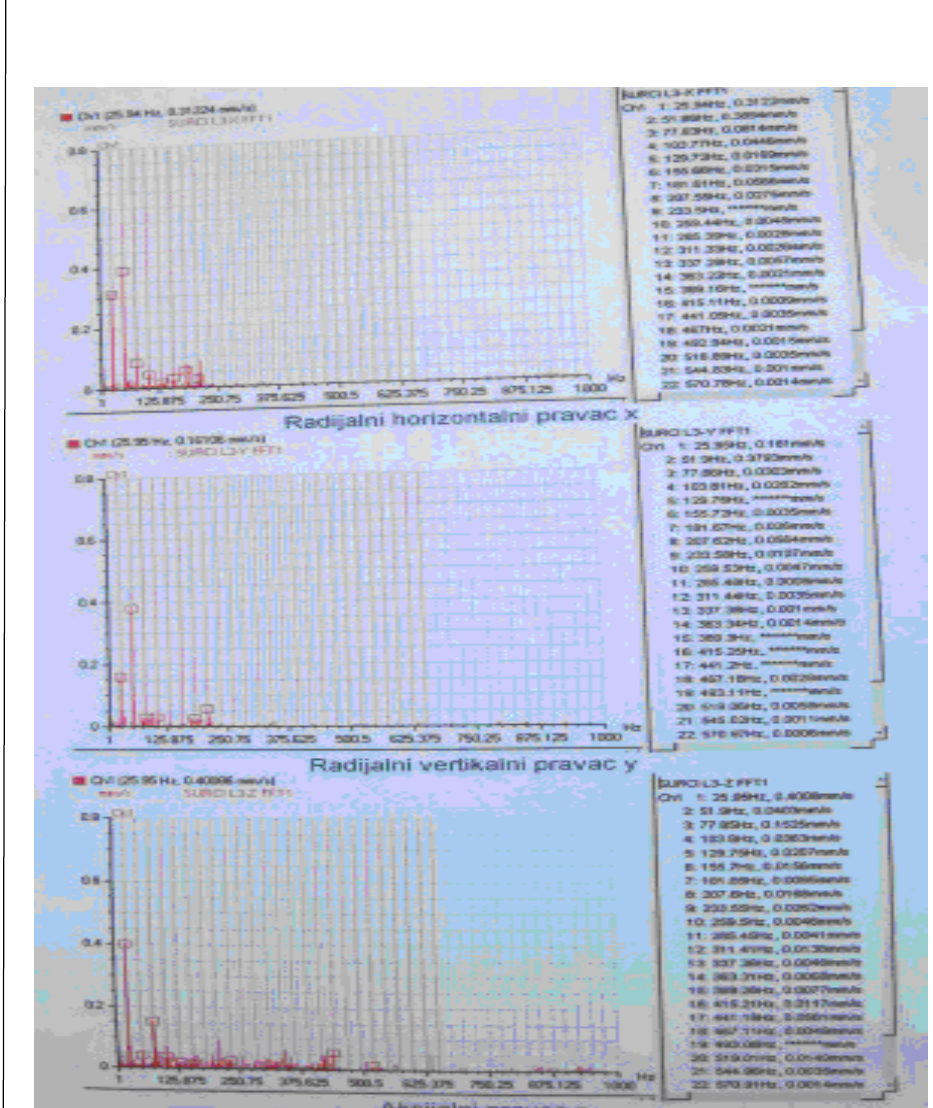
Figure 5 – Frequency spectrum of the measured vibrations and their analysis for bearing L5 Рис . 5 – Частотный спектр измеренных вибраций и их анализ на подшипнике